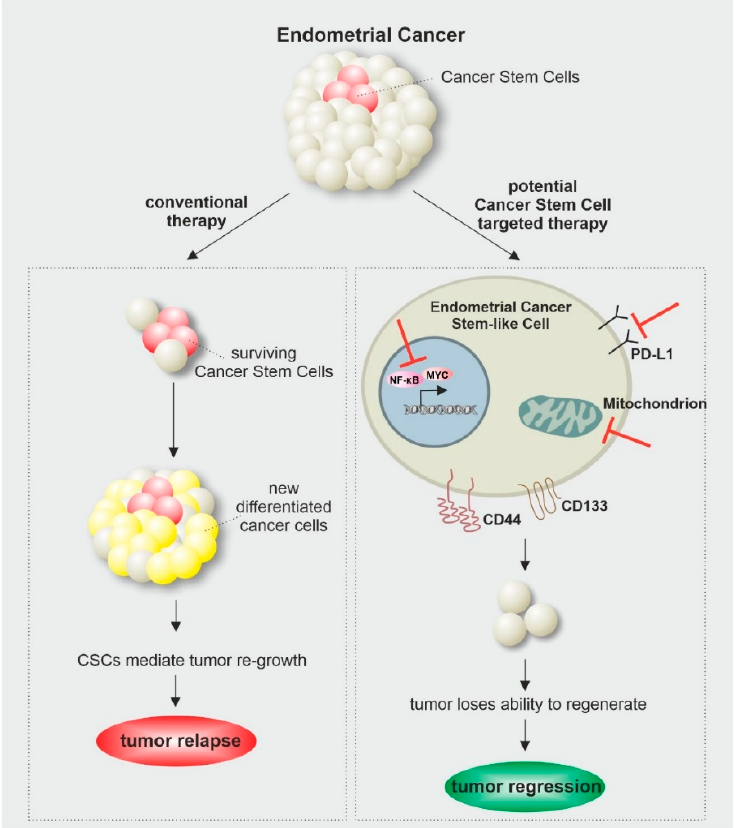
Figure 2. Endometrial Cancer Stem Cell as a therapeutical Target for Cancer Therapy.